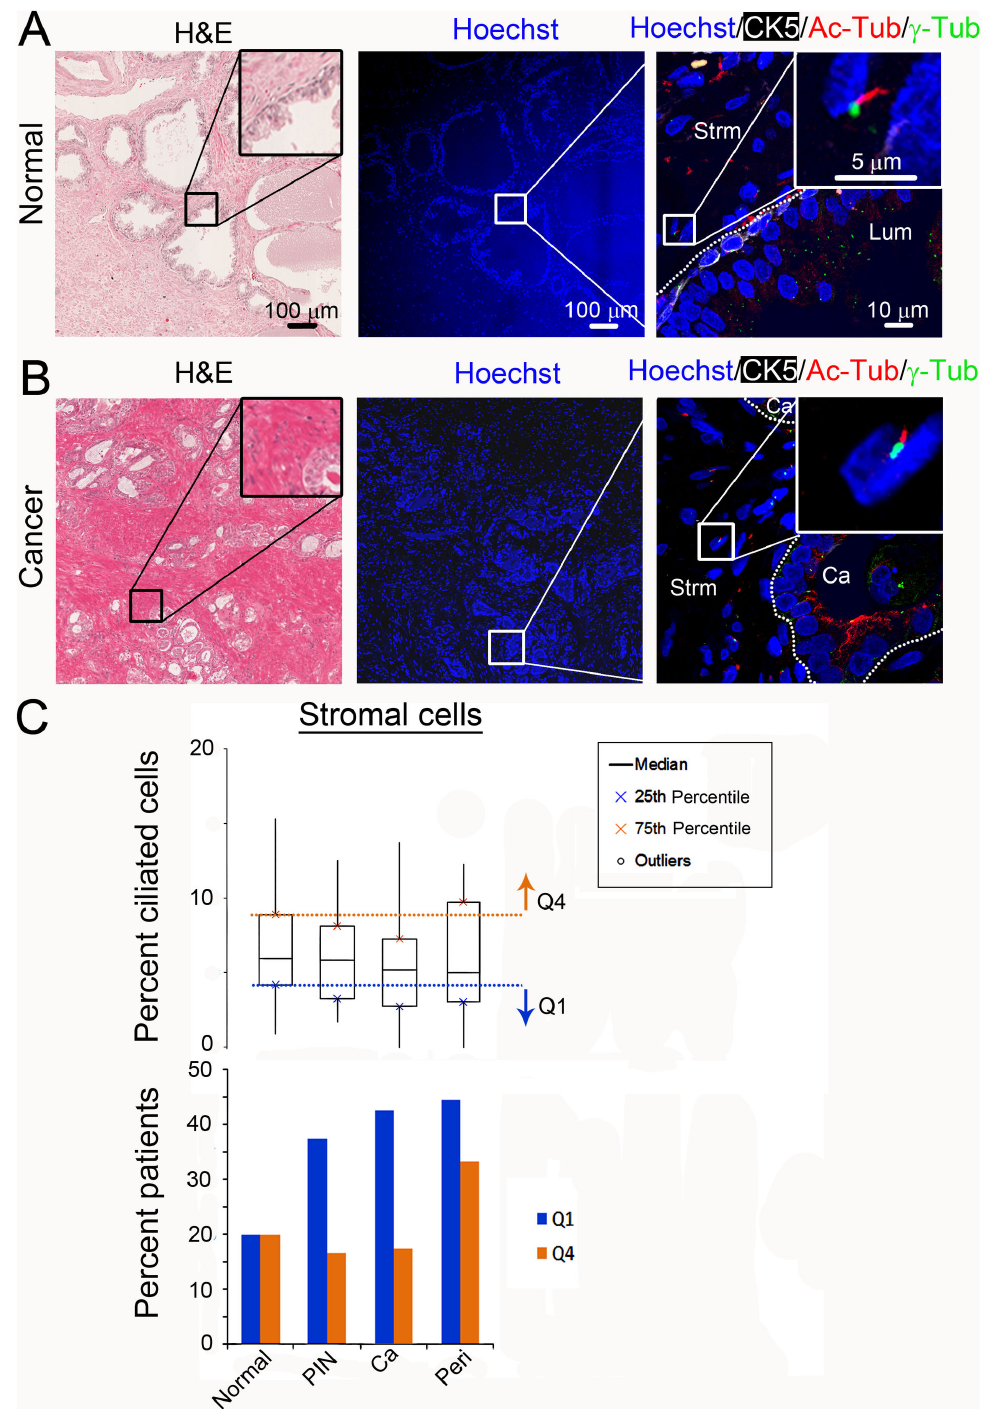
Figure 3. Frequency of cilia does not change on stromal cells surrounding cancer. Images of (A) normal prostate and (B) prostate cancer show nuclei (Hoechst; blue), cytokeratin 5 (CK5; white), primary cilia (Ac-Tub; red) and centrosomes (γ-Tub; green). Inset shows magnification of primary cilia on stromal cells associated with (A) normal tissue and (B) cancerous tissue (C, top). Boxplot describe the percent ciliated stromal cells per patient for each tissue type: normal, prostatic intraepithelial neoplasia (PIN), cancer (Ca), and perineural invasion (Peri). Q4, Q1 are as in Figure 1 (C, bottom). The percent of patients with an abnormally high percent cilia (Q4; orange) or an abnormally low percent cilia (Q1; blue).